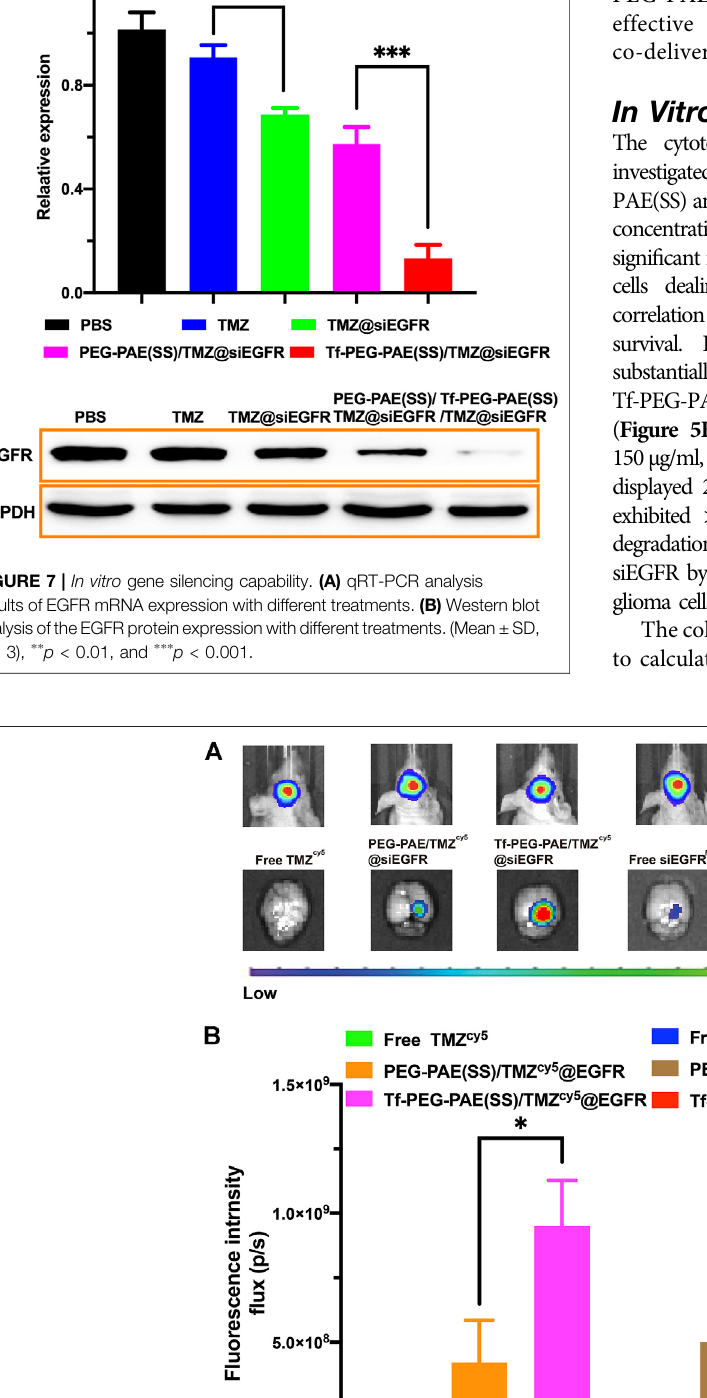
Frontiers in Genetics |